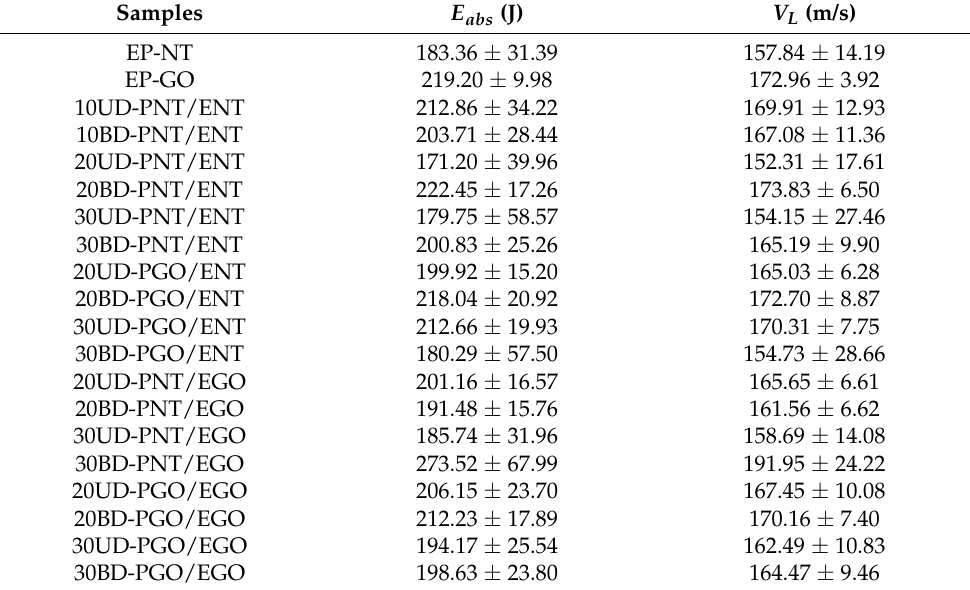
Table 4. Values acquired from the absorption energy